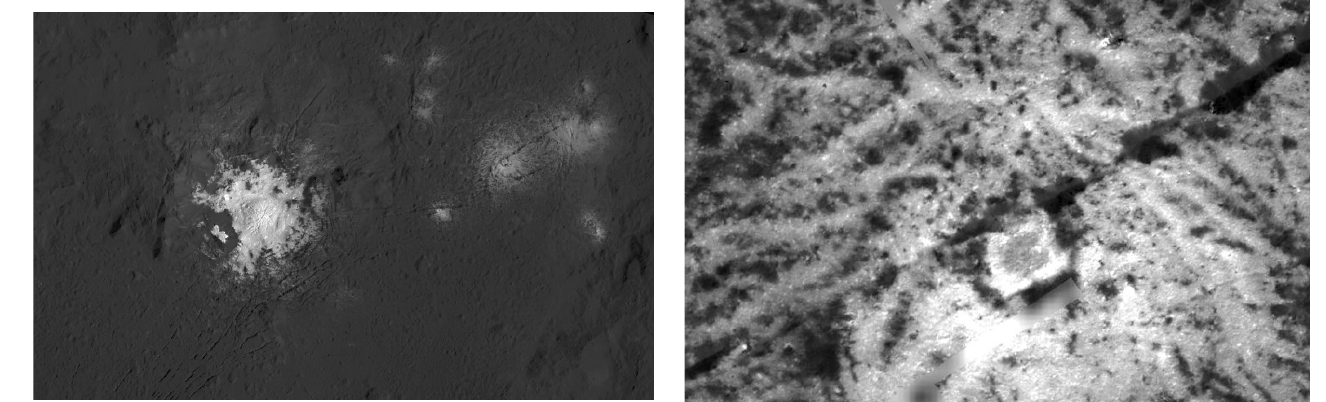
Figure 1. Left : Vinalia Faculae, Occator crater on Ceres. Right : Section image from original PIA21925. Original image credit: NASA/JPL-Caltech/UCLA/MPS/DLR/IDA/PSI. According to [1] “the ~17-km-wide and 4-km-high Ahuna Mons has a distinct size, shape, and morphology (Figure 2). Its summit topography is concave downward, and its flanks are at the angle of repose. The morphology is characterised by (i) troughs, ridges, and hummocky areas at the summit, indicating multiple phases of activity, such as extensional fracturing, and (ii) downslope lineations on the flanks, indicating rockfalls and accumulation of slope debris”. However, this debris accumulation is not so clearly sharply defined contour, which extends beyond, to the south and north sides of it. It is dome relaxation morphology [1].